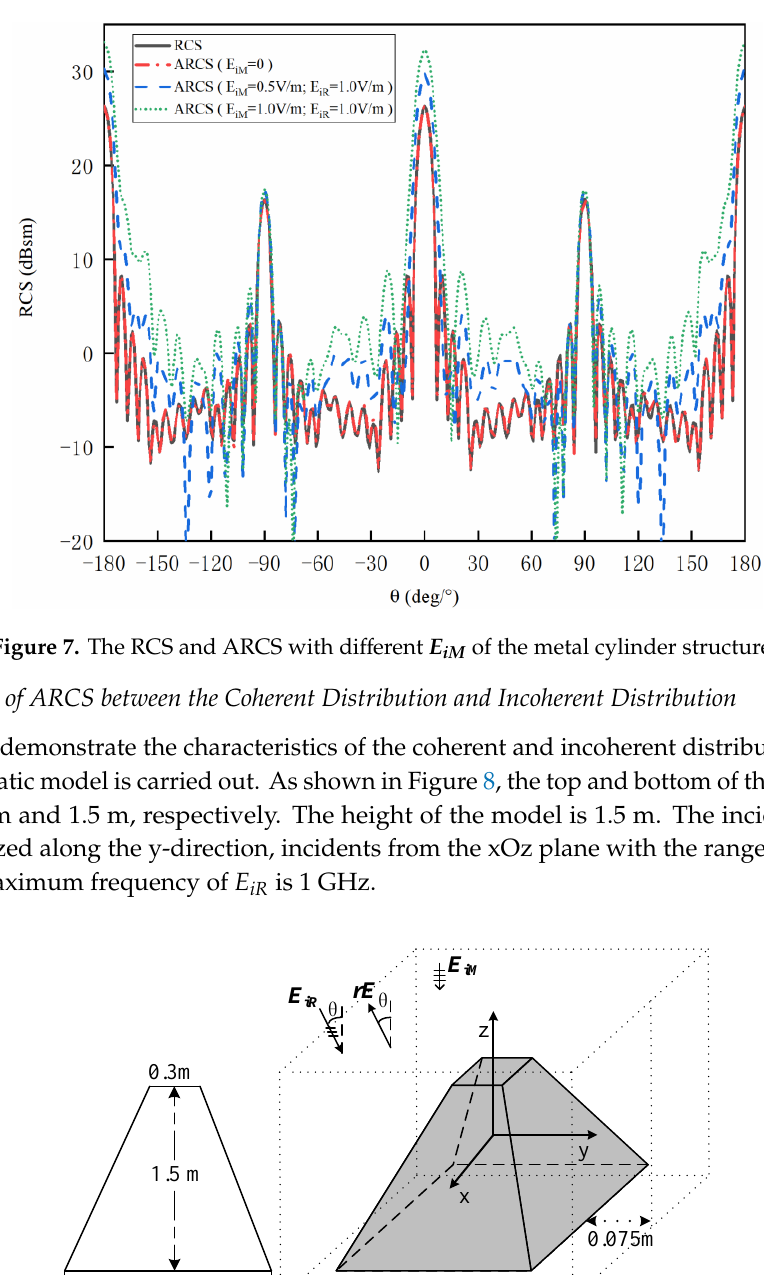
Figure 8. The model of the prismatic in the demonstration of the coherent and incoherent characteristics of ARCS.